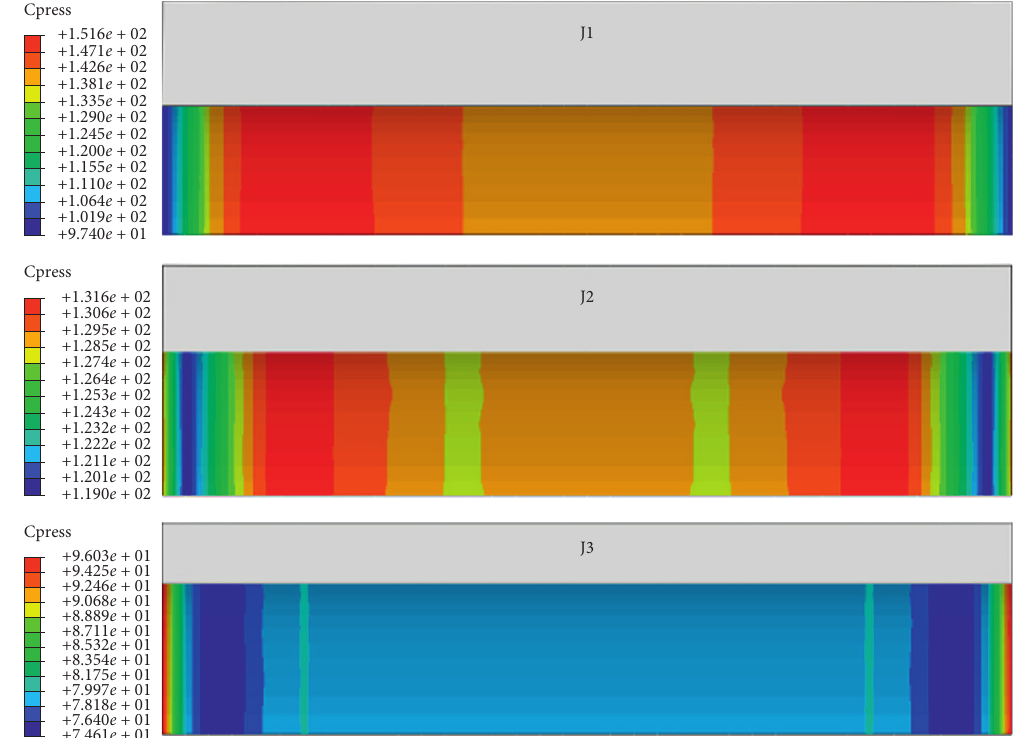
Figure 12: Contours map of pipe-joint interfacial pressures in J1, J2, and J3 at room temperature.